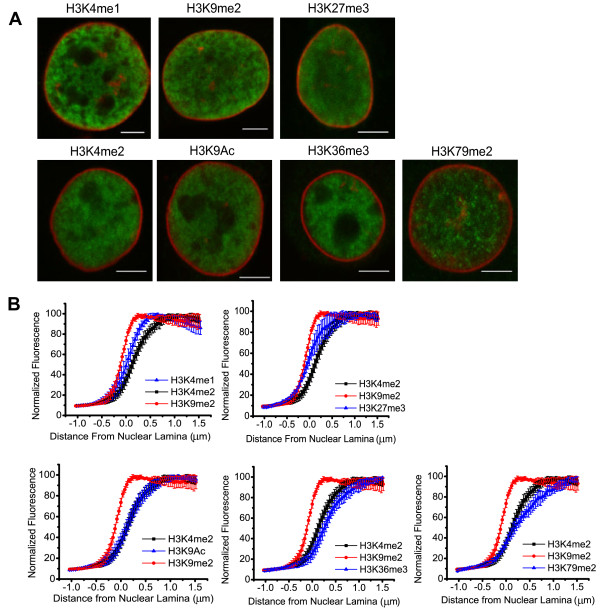
Localizations of histone modifications relative to the NL. (A) Representative immunofluorescence staining images of histone modifications (green) and lamin B (red) in C2C12 myoblast nuclei. Scale bars are 5 μm. (B) Radial intensity plots integrated over the entire contour of NL from representative cell nucleus images of histone modifications: H3K4me1 (n=6), H3K4me2 (n=6), H3K9Ac (n=7), H3K9me2 (n=4), H3K27me3 (n=6), H3K36me3 (n=8), and H3K79me2 (n=9). Distances from the NL (x-axis labels, in μm) switch from negative to positive values where locations to measure pixel intensities progress from outside the NL to inside the NL, as described previously [23]. H3K4me2 (black) and H3K9me2 (red) intensities were used in each plot to represent histone modifications located away from the NL and located towards the NL, respectively. Error bars represent standard deviations. Two-sample t-test results of the normalized immunostaining fluorescence intensities within 0 to 0.5 μm distance from the NL center are the following: H3K4me2 vs H3K9me2: p < 0.001, H3K4me2 vs H3K27me3: p < 0.01, H3K4me2 vs H3K4me1: p < 0.05, H3K4me2 vs H3K9Ac: p = 0.95, H3K4me2 vs H3K36me3: p < 0.05, H3K4me2 vs H3K79me2: p = 0.08, H3K9me2 vs H3K4me1: p < 0.01, H3K9me2 vs H3K27me3: p < 0.01.